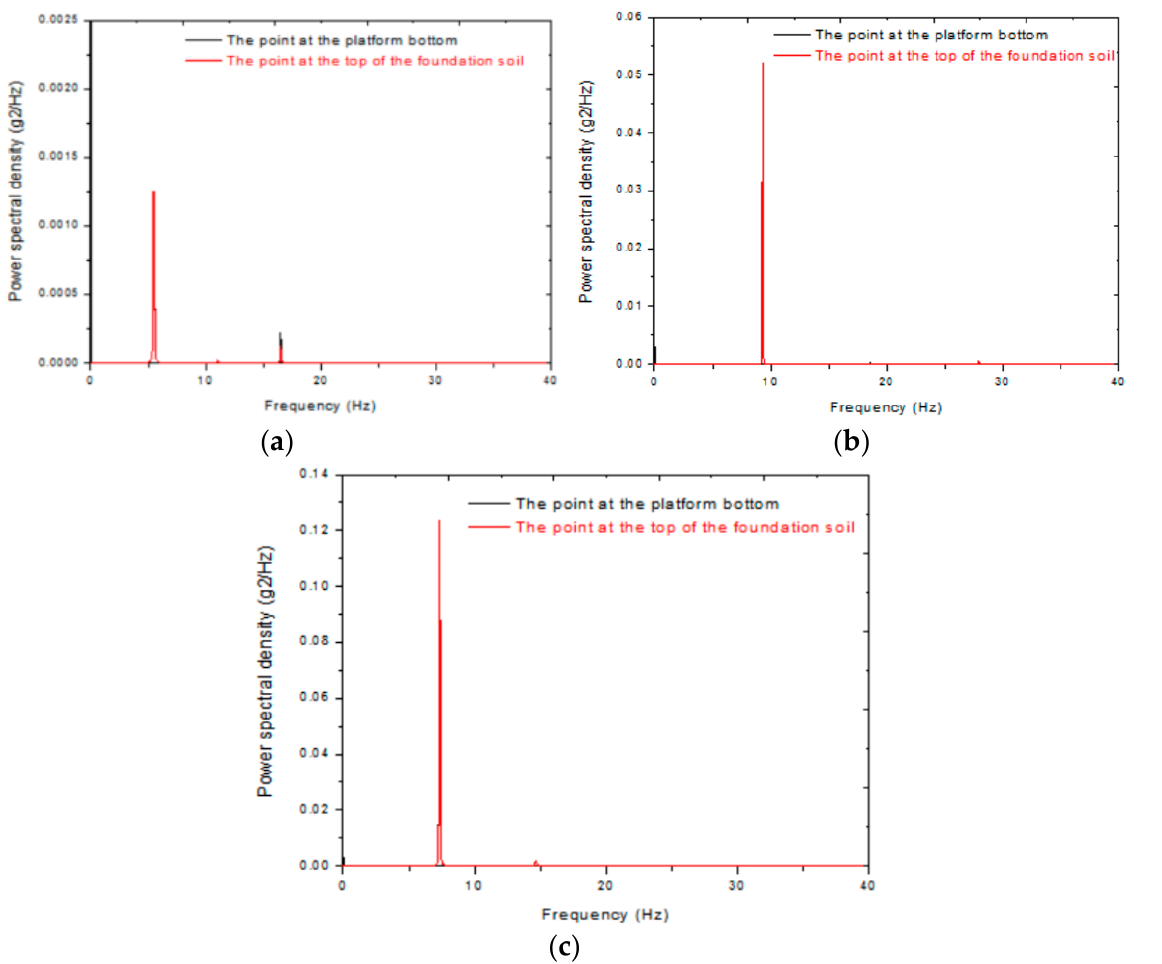
Figure 12. Phase-Plane Curves of “Adjacent” Measuring Points at Pile Cap-Soil Interface under Sinusoidal Excitation: ( a ) S5-1, ( b ) S5-2, ( c ) S10. Figure 13. Acceleration Auto-power Spectrum Density curves of “Adjacent” Measuring Points at